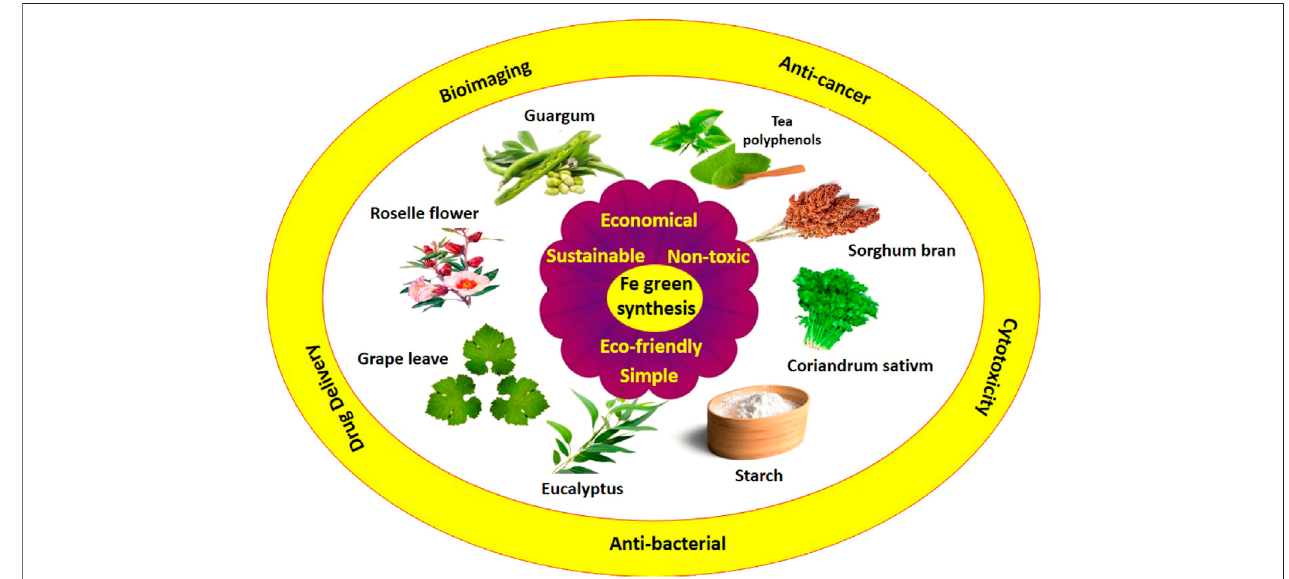
FIGURE 1 | Green capping agent used for the preparation of Fe nanoparticles.